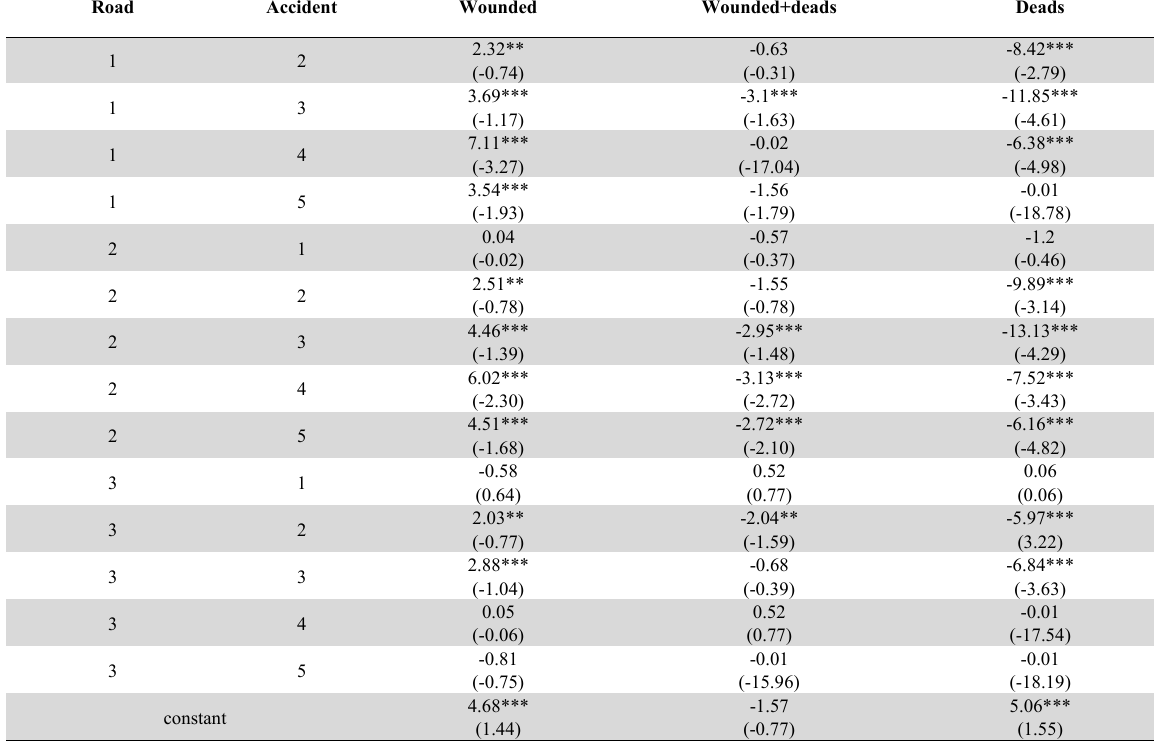
Relationship between road accidents and road types alongside with accident type Road